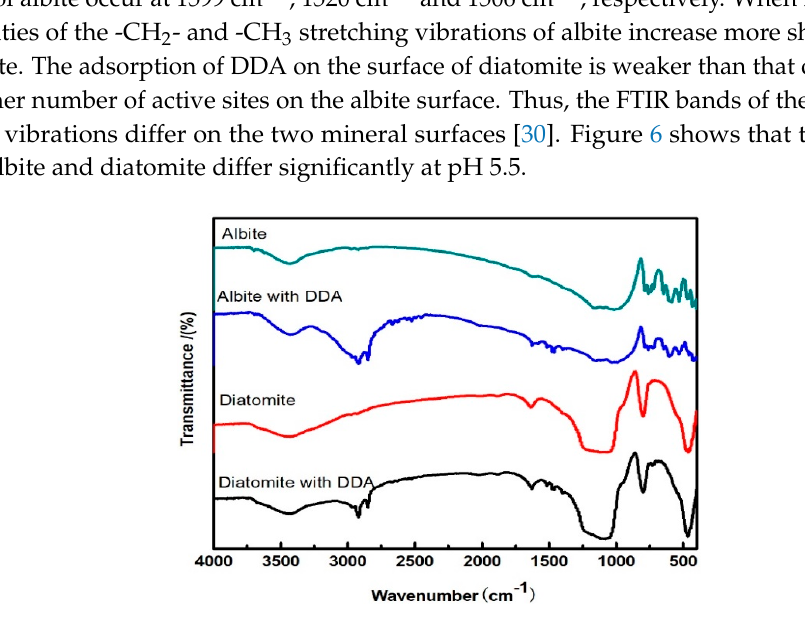
Figure 6. FTIR spectra of untreated diatomite and albite, and FTIR spectra of diatomite and albite treated with 2.38 × 10 ‒ 4 mol/L DDA at pH 5.5.